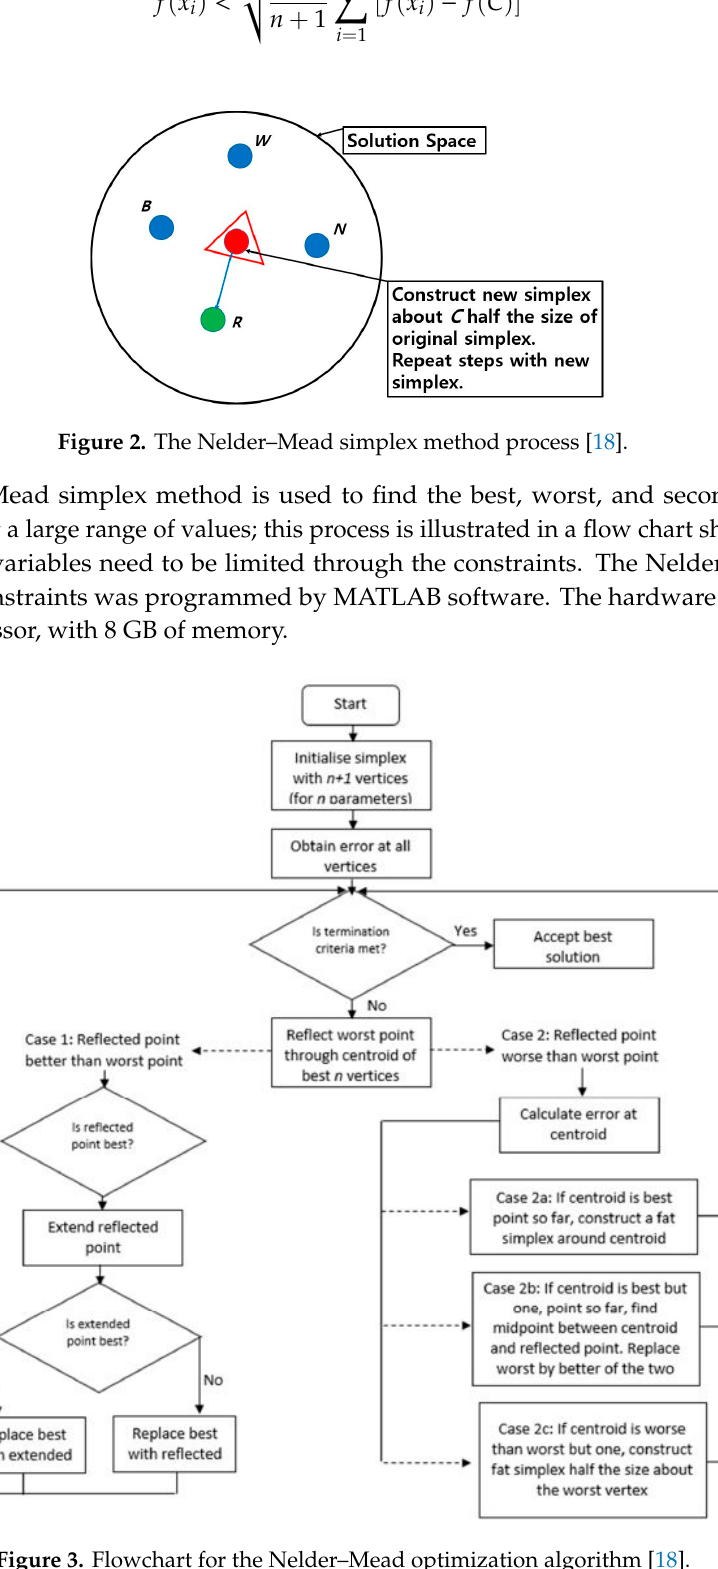
Figure 3. Flowchart for the Nelder–Mead optimization algorithm [18].